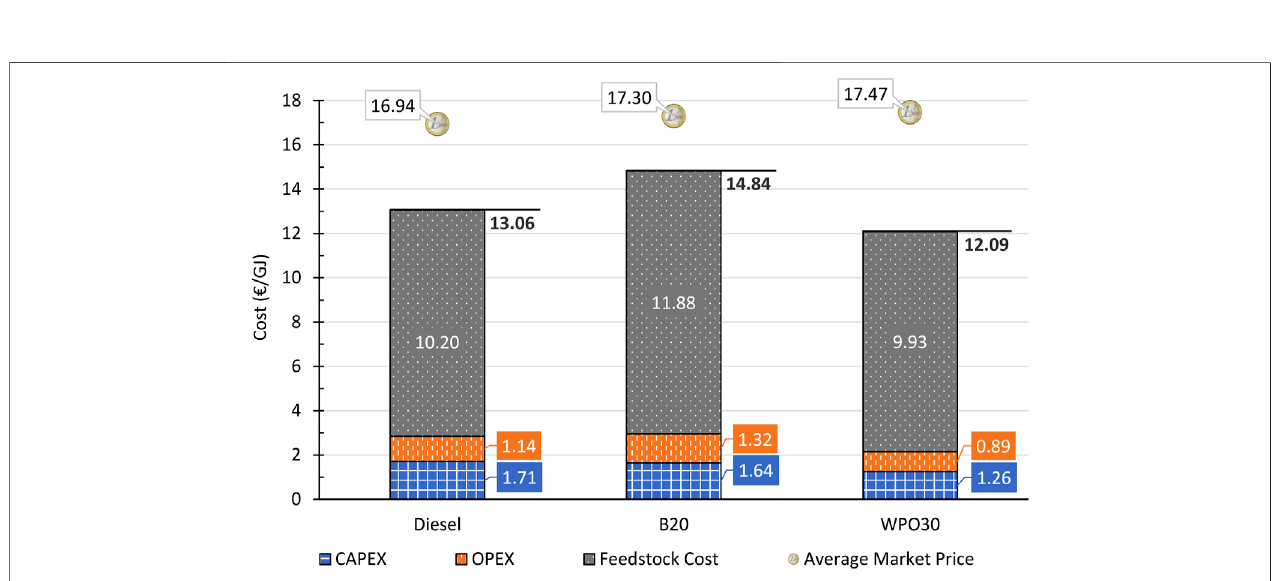
FIGURE4 | Economic comparison oftraditionaldiesel against proposed blends withbiodiesel (B20)and WPO (WPO30). B20: Diesel/Biodiesel blend 80/20% v/v. WPO30: Diesel/Plastic waste pyrolysis oils 70/30% v/v (for references, see Table 3 ).